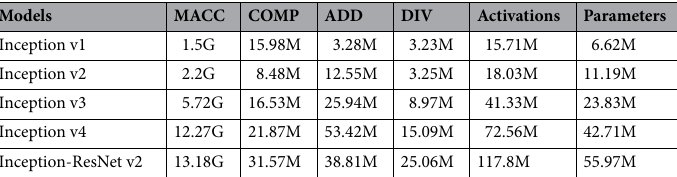
Table 1. Comparison of the Inception models 34 . MACC = Multiply and accumulate, COMP = comparison, ADD = addition, DIV =